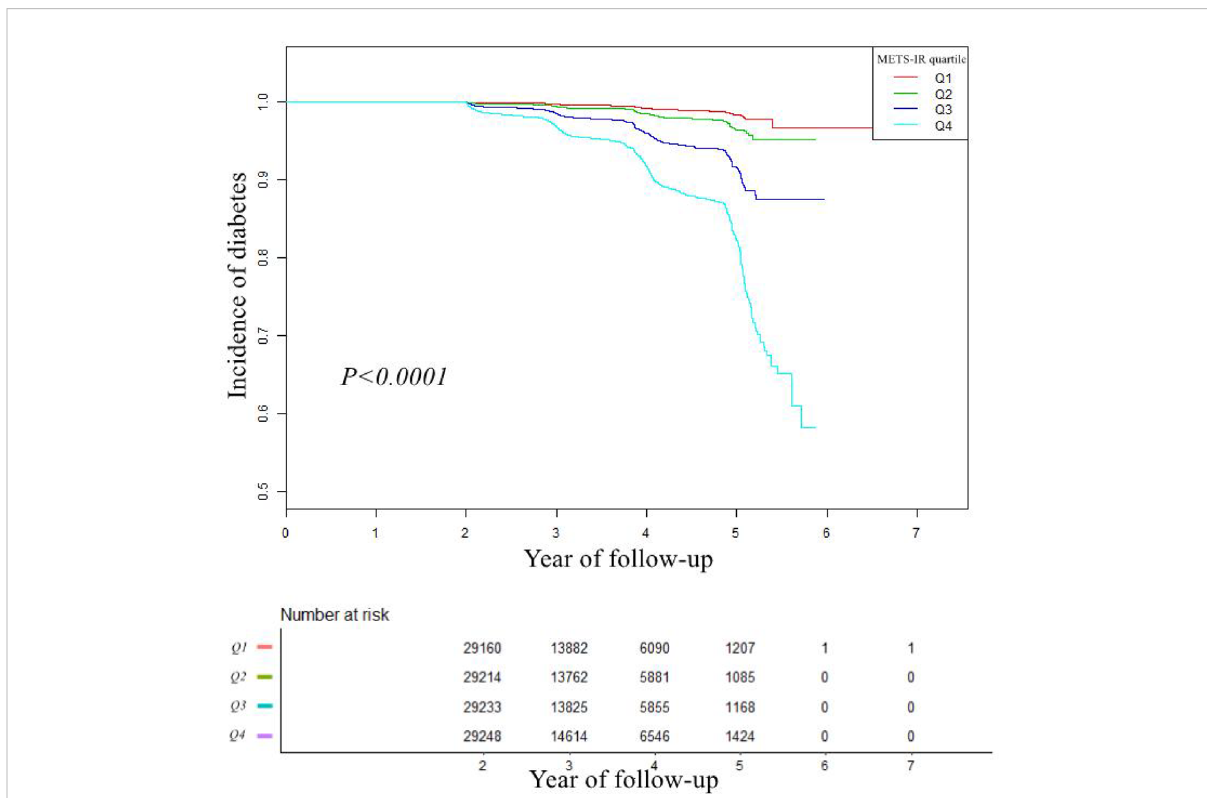
FIGURE 1 Kaplan – Meier event-free survival curve. Kaplan – Meier analysis of incident of diabetes based on METS-IR quartiles (Log-rank, P < 0.0001). Abbreviation: METS-IR: the metabolic score for insulin